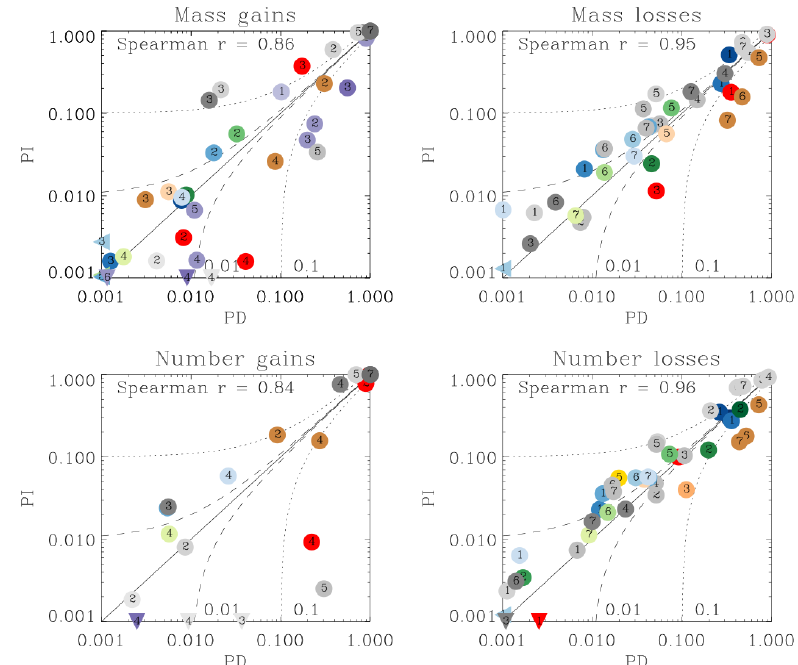
Figure 25. Fractional tendencies for the pre-industrial experiment versus the present-day experiment. Colors indicate processes (Table 2), numbers indicate modes (Table 3). Results are shown for North America.